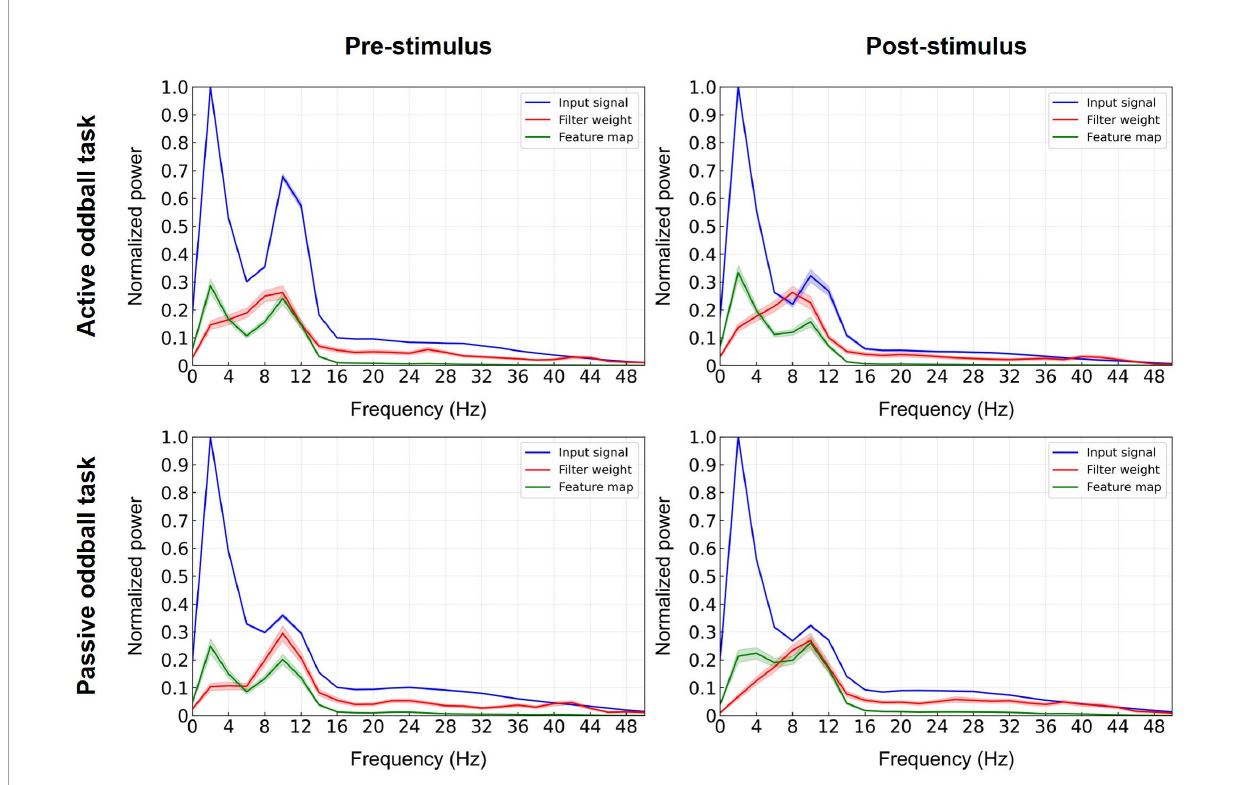
FIGURE6 Decisive EEG spectral features in the decoding model. The input signals (blue lines), learned filter weights of the first convolutional layer (red lines), and corresponding feature maps (green lines) of the EEGNet model trained on broadband data were projected to the frequency domain using Fast Fourier Transform (at electrode Pz) and spectra were averaged over the 11 cross-validation folds. Error bands indicate standard errors of the